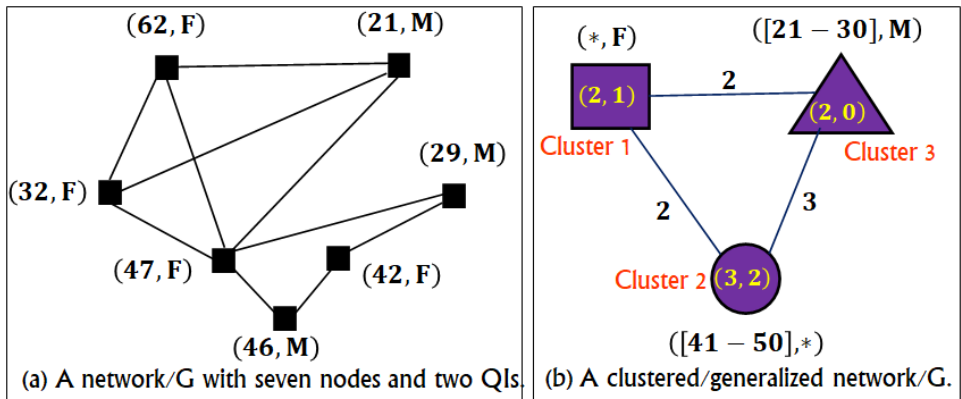
Figure 15. Overview of graph generalization/clustering methods.